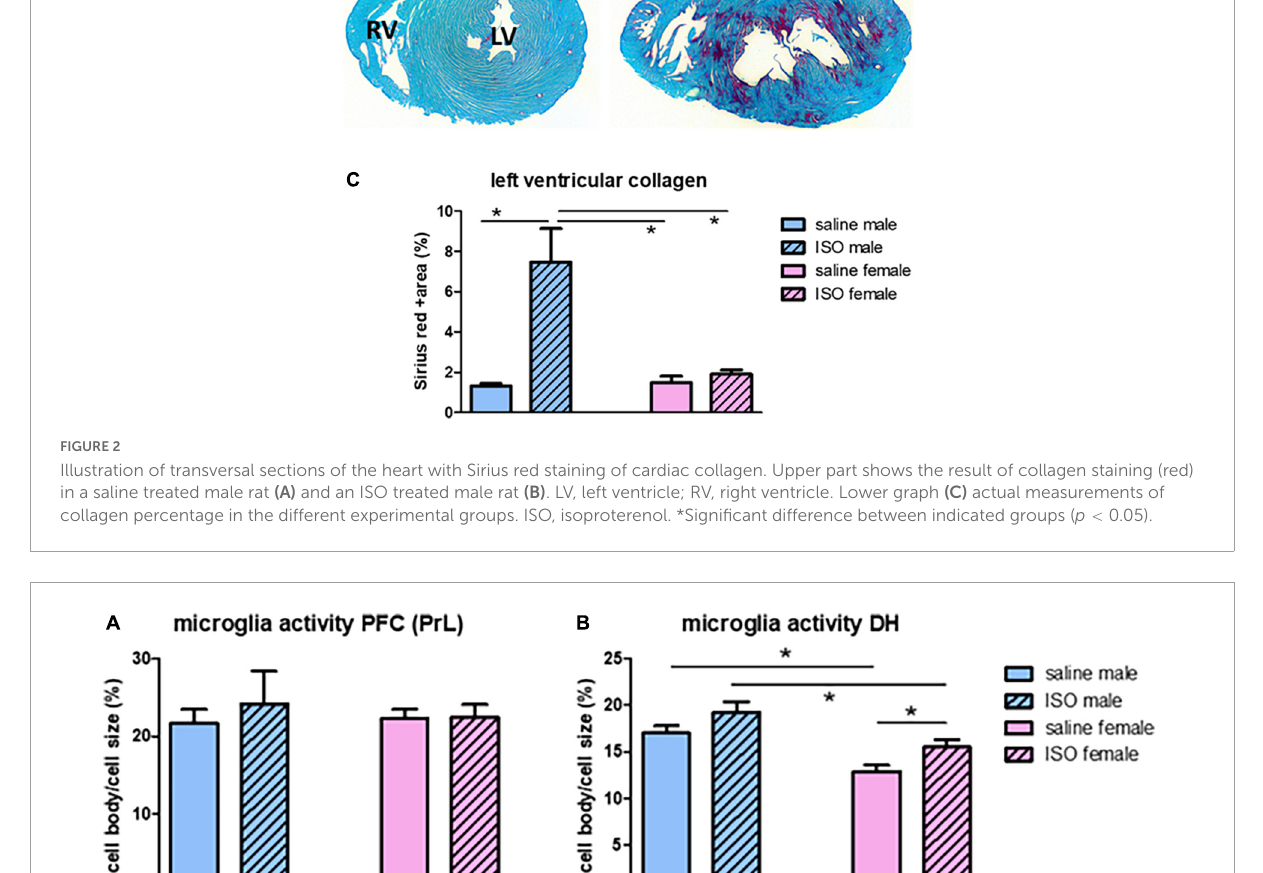
tests. In the OF, time spent at the wall showed significant sex differences; male rats spent more time in this area ( Figure 6A ). Similarly, male rats paid significantly less visits to the center area ( Figure 6B ). No significant effects of ISO were observed. However, a significant interaction between the two factors, sex and treatment, for both parameters indicated that male rats became more anxious after ISO, whereas females did not.